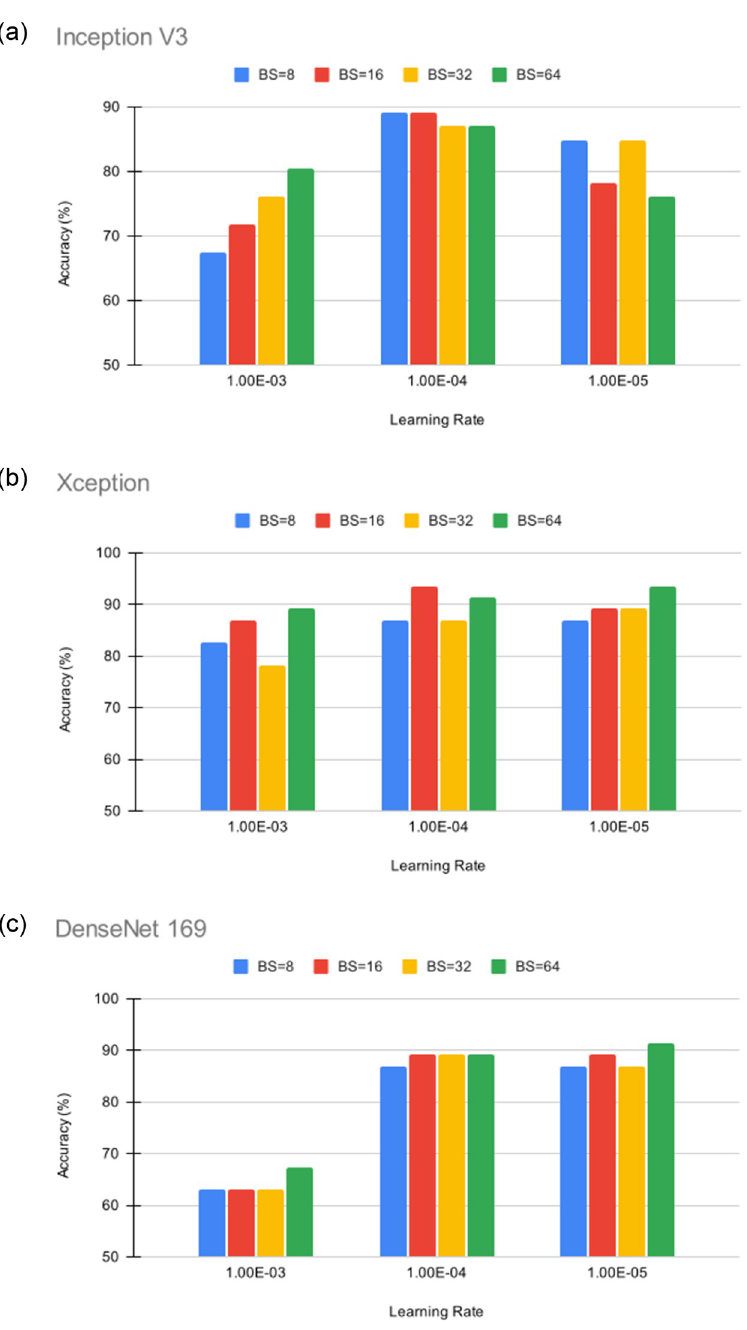
Fig 6. Ablation study concerning different batch sizes and learning rates on the Fold-1 of the dataset. The base models are mentioned on the top of each of the bar